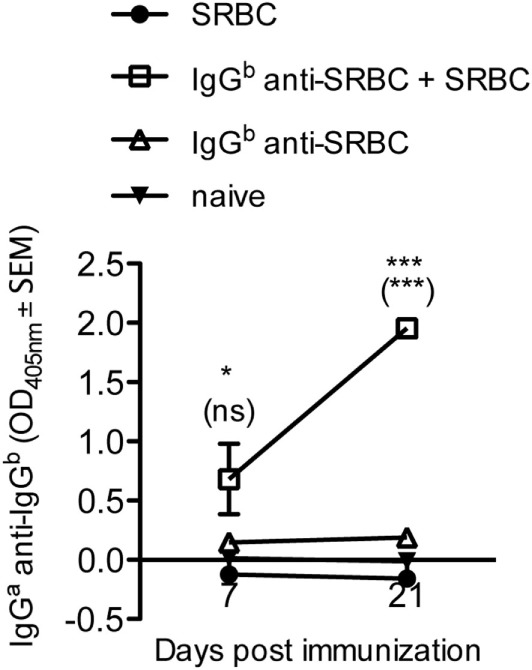
Immunization with IgG anti-SRBC together with sheep red blood cells (SRBC) generates an anti-IgG response. BALB/c mice were immunized with 10 µg allogeneic IgGb anti-SRBC (open squares) 30 min prior to immunization with 5 × 106 SRBC. Controls were immunized with 5 × 106 SRBC alone (filled circles), 10 µg IgGb anti-SRBC alone (open triangles), or left unimmunized (solid triangles). Sera were diluted 1:25 and screened for IgGa anti-IgGb by enzyme-linked immunosorbent assay. p-Values for comparisons of mice immunized with IgGb anti-SRBC and SRBC versus SRBC alone are given without parentheses. Comparisons of mice immunized with IgGb anti-SRBC and SRBC versus IgGb anti-SRBC alone are given within parentheses. Data are representative of three independent experiments (n = 5/group, except for IgGb anti-SRBC alone and naive groups where n = 2/group) (ns, p > 0.05; *p < 0.05; **p < 0.01; ***p < 0.001).